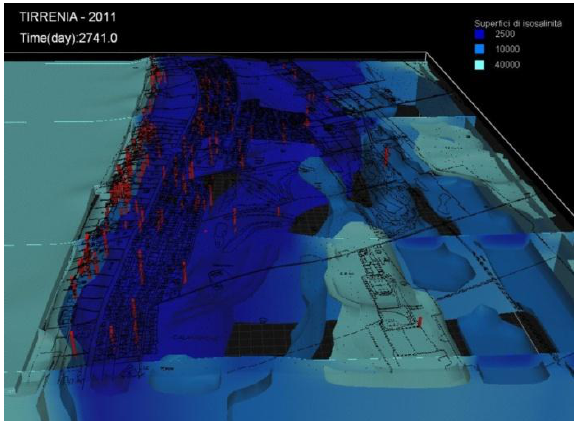
Figure 3. Baseline scenario for the Tirrenia area (3D view obtained by Modflow 3D Visual Explorer). Salinity distribution (mg/l) at the end of the simulation period